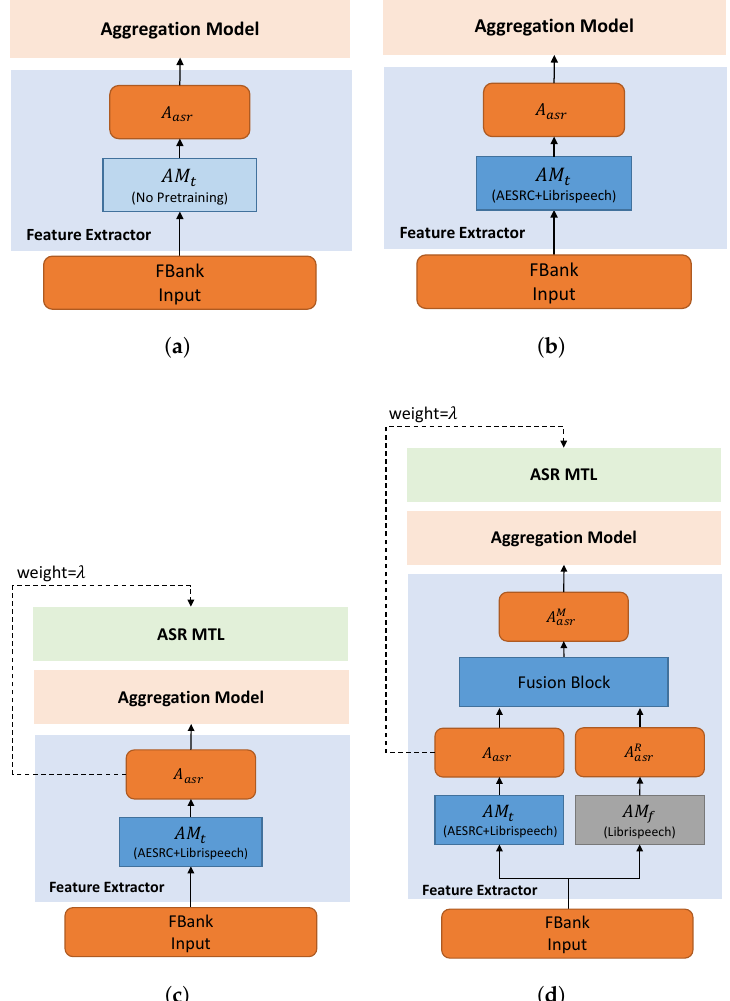
Figure 3. Different training methods. ( a ) Directly train the whole model for the AR task. ( b ) Pretrain the acoustic model for ASR and then train the whole model for AR. ( c ) Pretrain the acoustic model for ASR and then train the whole model for AR and ASR MTL (weight = λ ). ( d ) The proposed hybrid method. Based on ( c ), the non-accented embedding is merged for